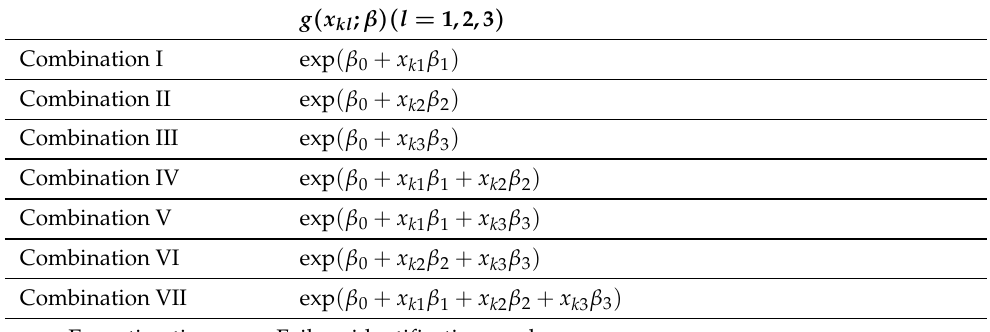
Table 3. Combination of covariates g ( x kl ; β ) .